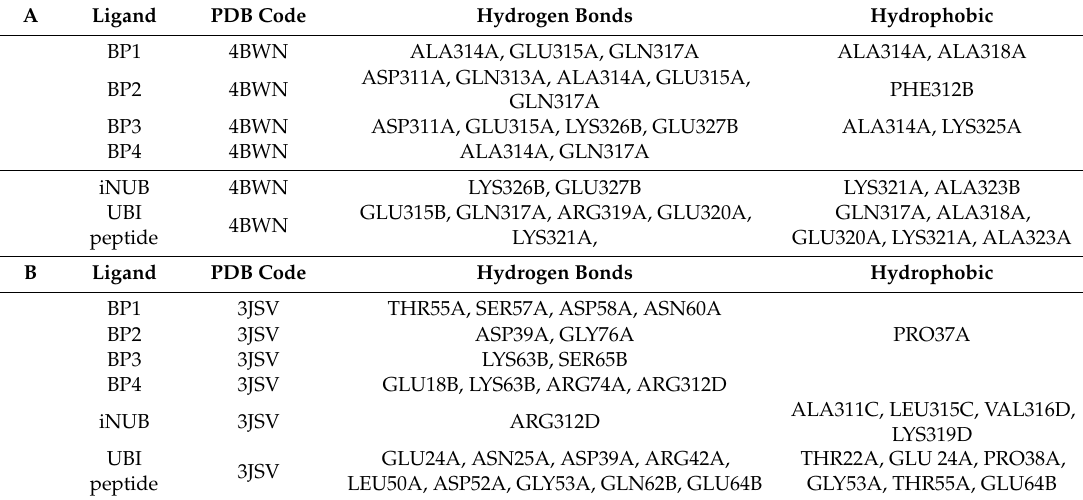
Table 3. Blind docking simulation results showing the main residues involved in the interactions with the docked BP and compounds. ( A ) Docking to 4BWN PDB. ( B ) Docking to 3JSV PDB. Common residues are marked in bold.